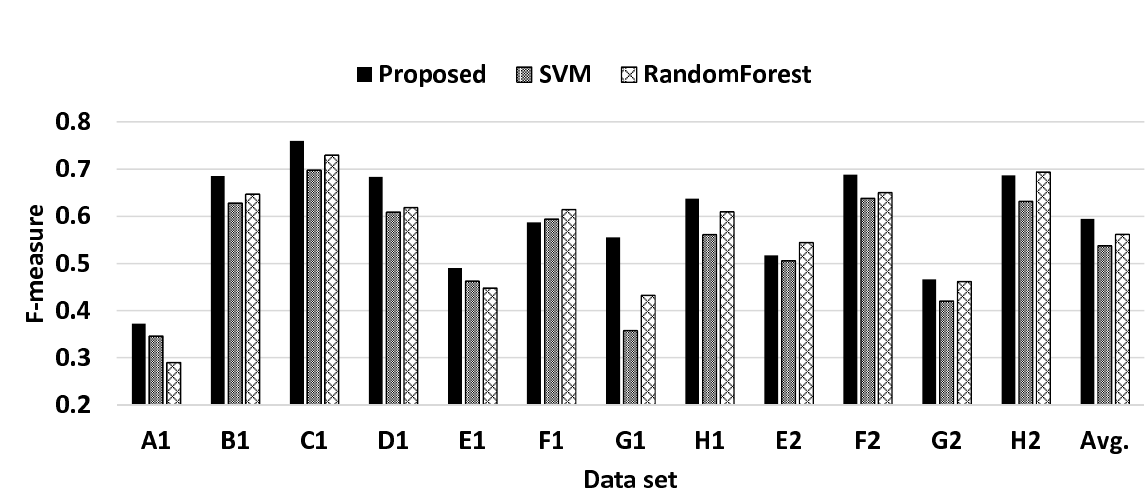
Figure 5: Facial expression accuracy of each